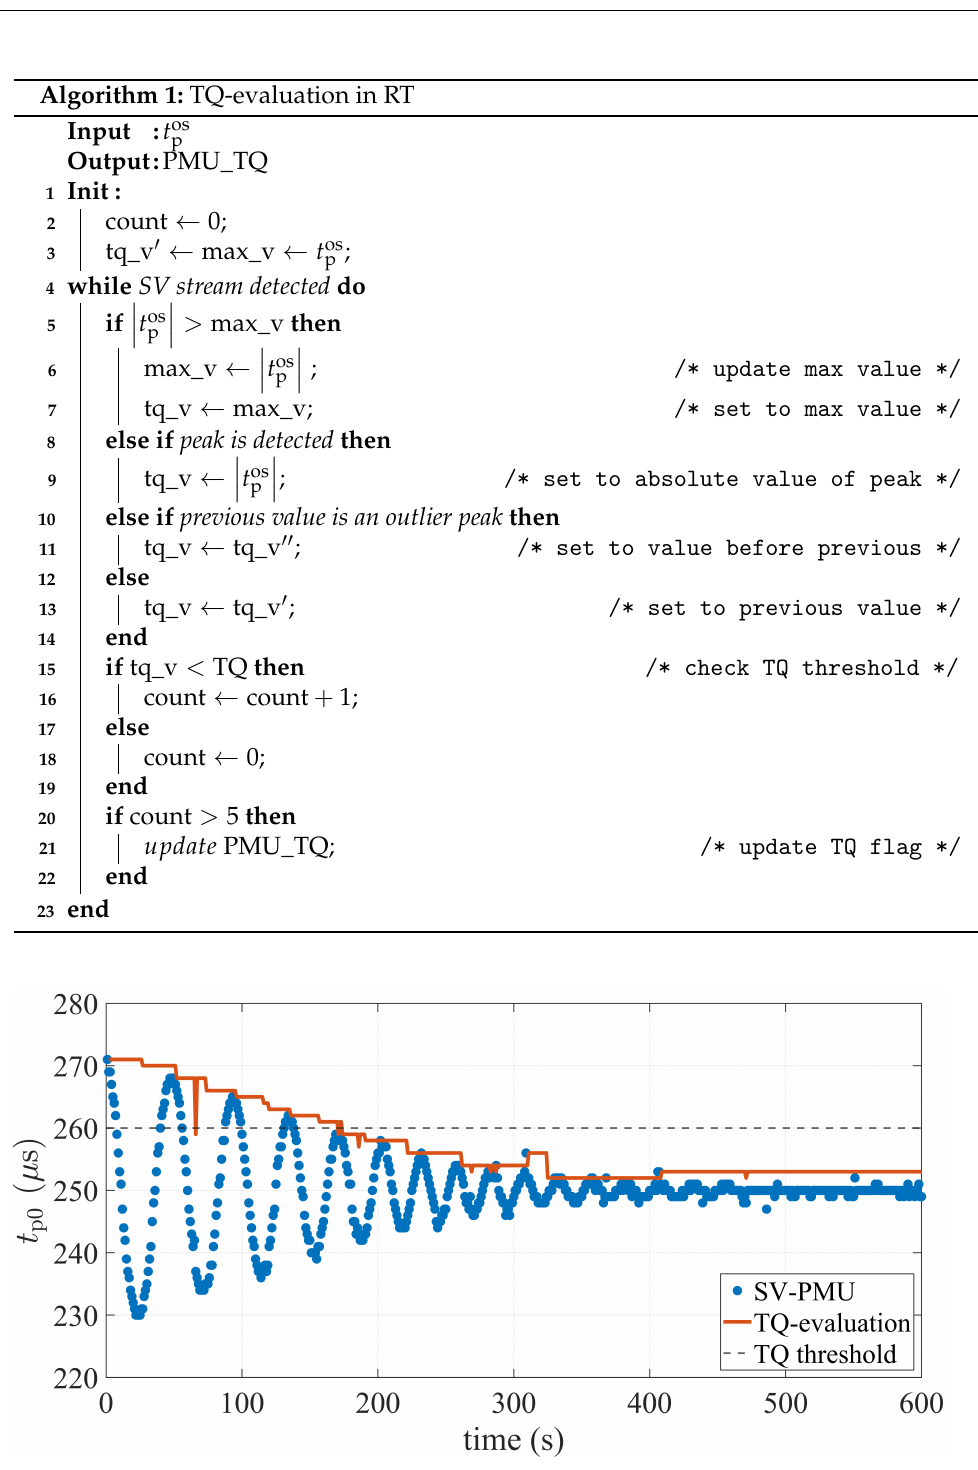
Figure 6. t p0 as measured by the SV-PMU (dots) vs. time and RT time quality evaluation algorithm values (solid line). Dashed line represents the time quality threshold of 10 µ